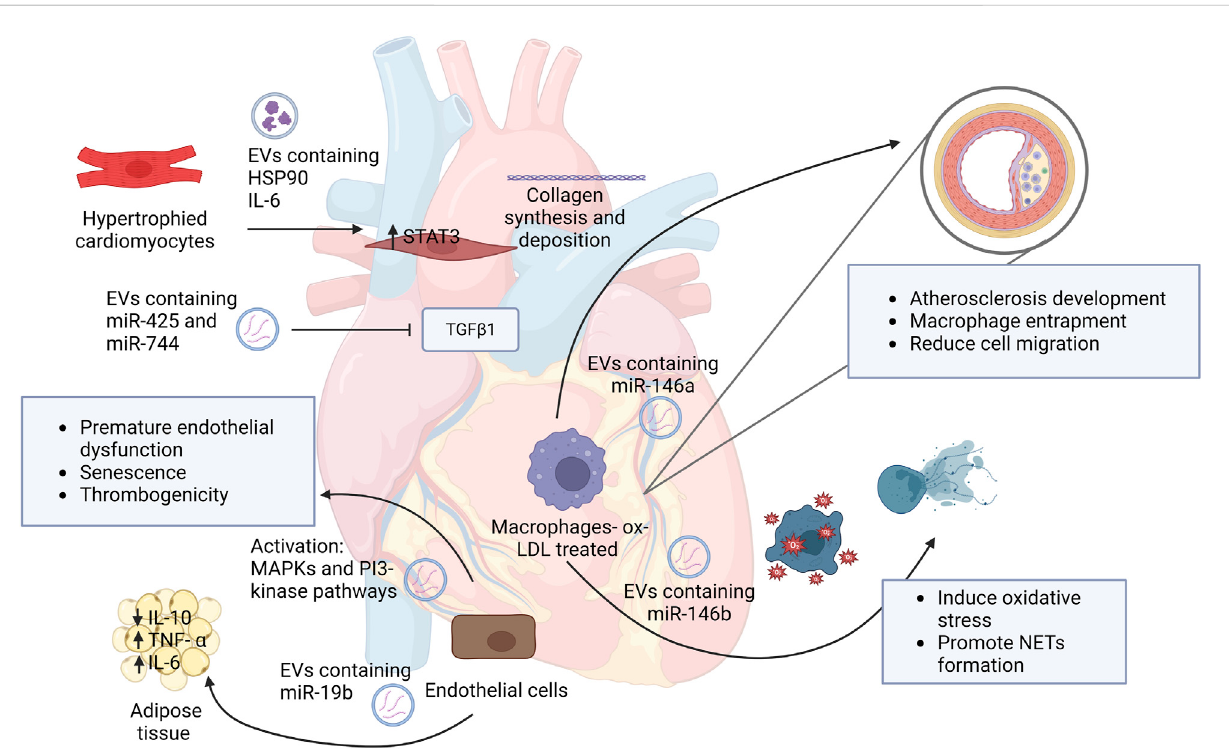
FIGURE 1 Schematic representation of EVs roles in the development and progression of cardiovascular diseases. This fi gure demonstrates the role of EVs and theircargoonneighborcellsandhowtheycontributetodiseaseinitiation.Abbreviations:HSP90,heatshockprotein90;IL-6,interleukin6;STAT3,signal transducer and activator of transcription; MAPKs, Mitogen-activated protein kinases; IL-10, interleukin 10; TNF- α , tumor necrosis factor alpha; ox-LDL, oxidized low-density lipoprotein; NETs, neutrophil extracellular traps. Created with